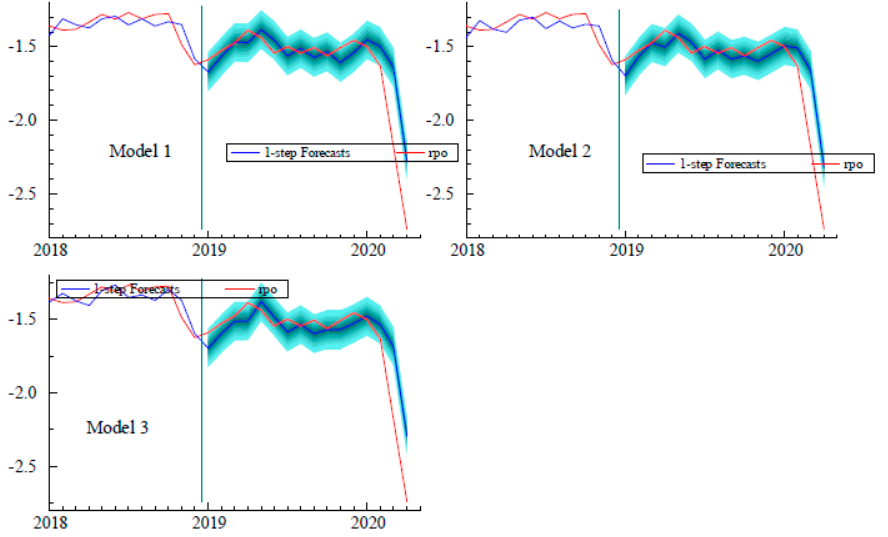
Figure 9. Out-of-sample 1-step ahead forecasts for the real price of oil. Sensitivity to Model Specification.